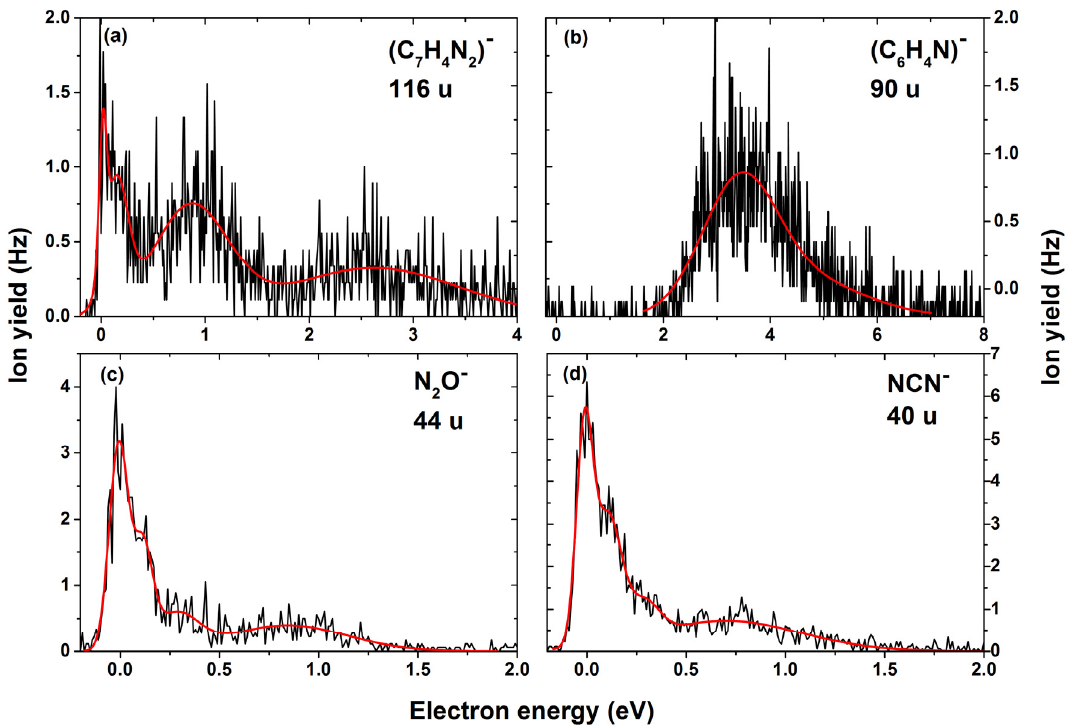
Figure 4. Anion efficiency curve for the formation of the anions with masses ( a ) 116 u, ( b ) 90 u, ( c ) 44 u and ( d ) 40 u upon electron attachment to tirapazamine.